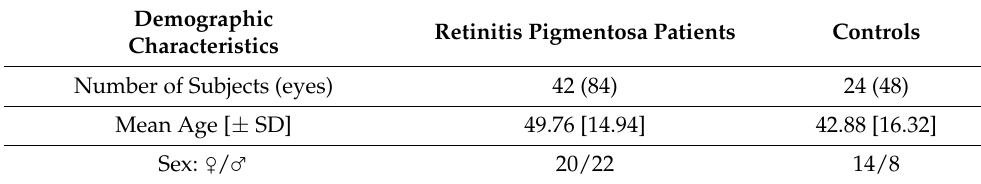
Table 1. Demographic data of our RP patients and